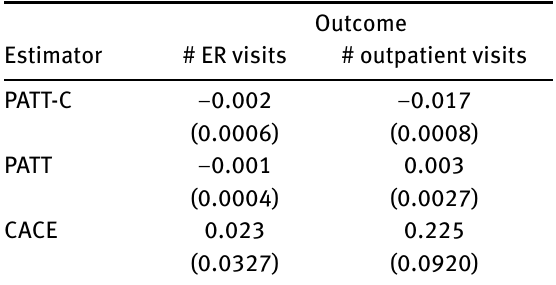
Table 1: Comparison of population and sample estimates.